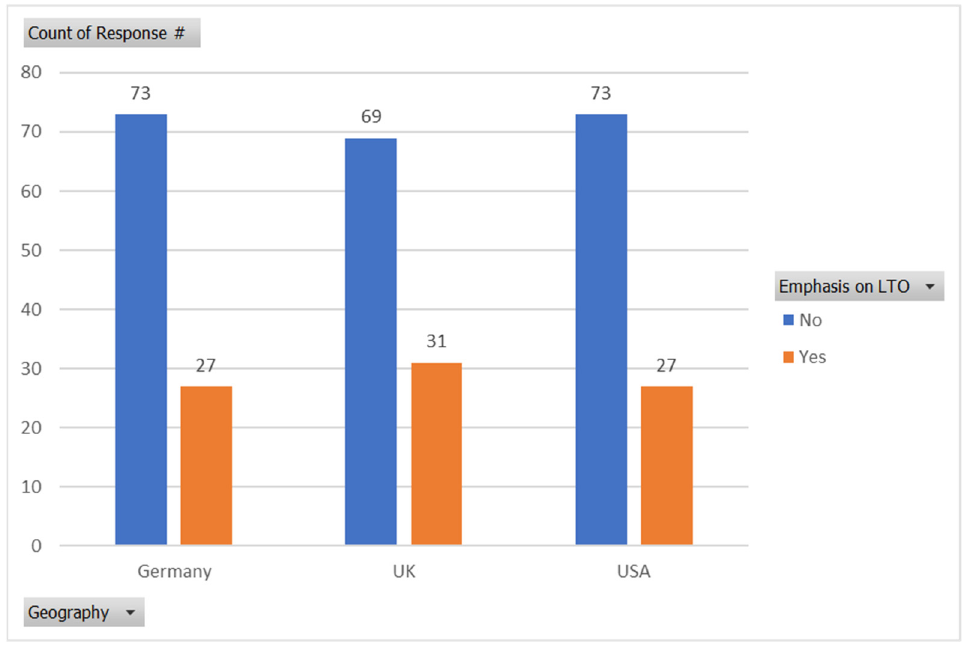
Figure 4. Long-term orientation of managers by country.